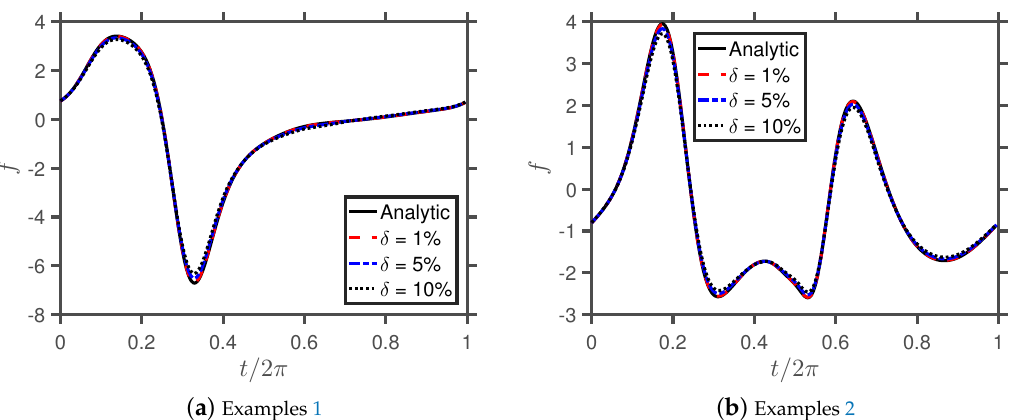
Figure 2. The numerical solutions of the temperature obtained using the presented method, and various amounts of noise added in the boundary data, on ∂ D .